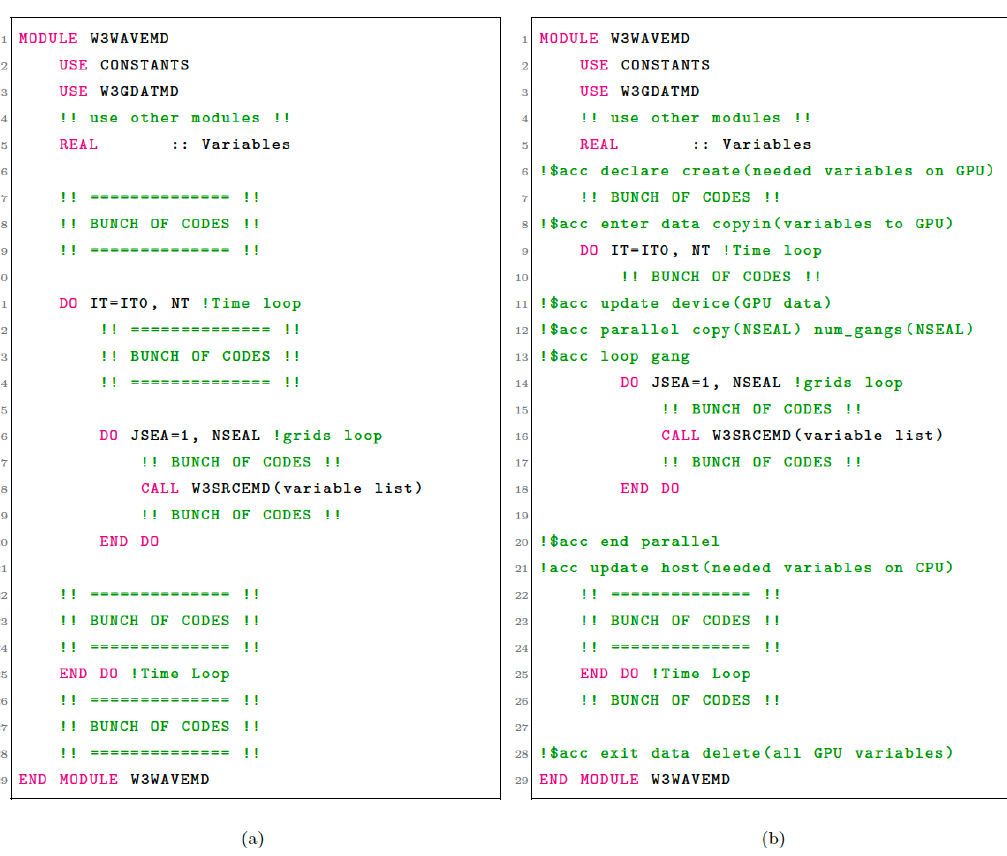
Figure 3. A schematic representation of the WAVEWATCH III original Fortran source code for the W3WAVEMD module (a) and its OpenACC directives version (b)